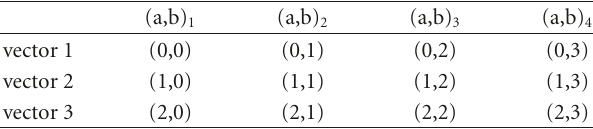
Table 3: Writing without permutation.